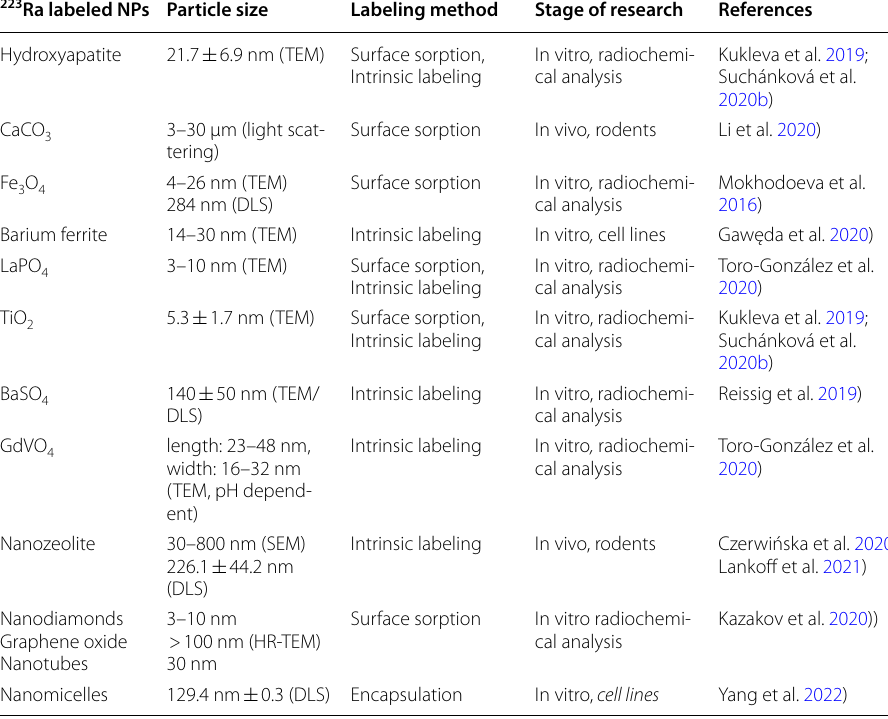
223 Ra labeled NPs Particle